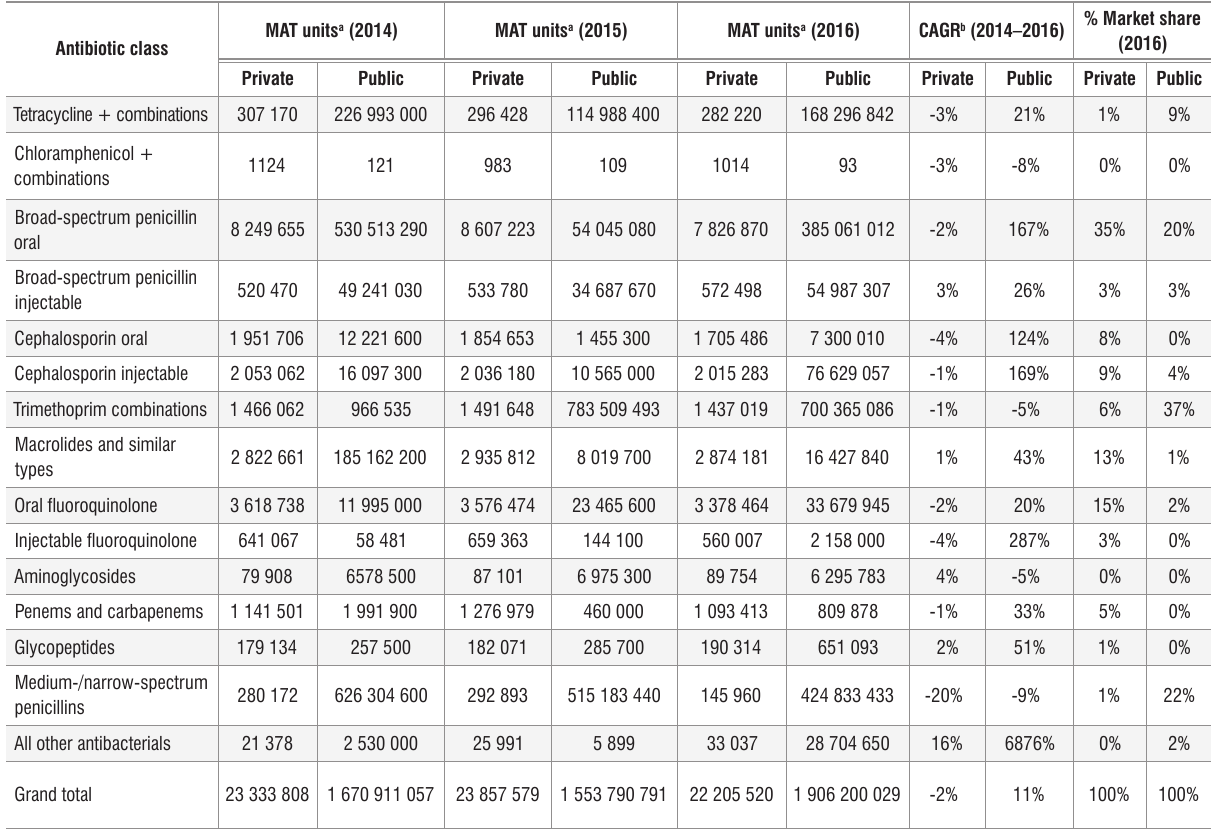
Antibiotics sold in the private and public sector from 2014 to 2016 MAT units a Antibiotic class